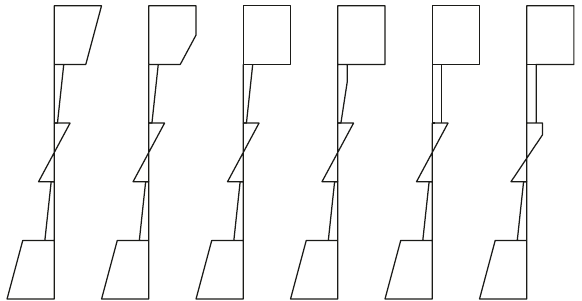
Figure 6: Stress evolution on the cross section in CLTof five layers.